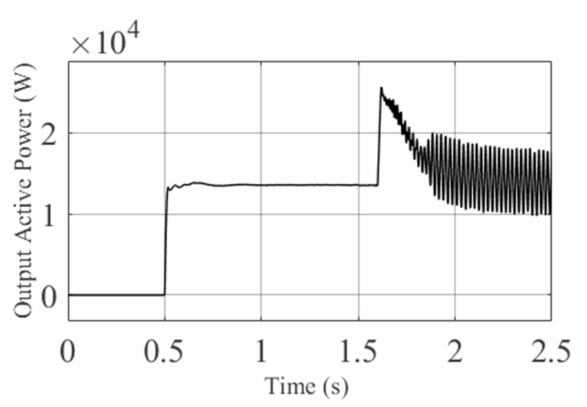
Figure 19. Output active power of the